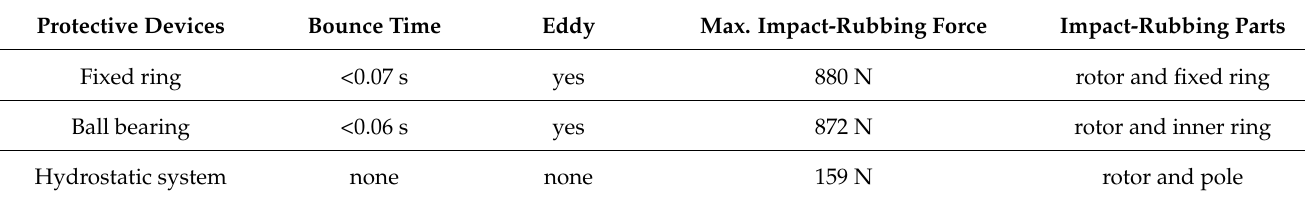
Table 2. Influence of upper unit failure on